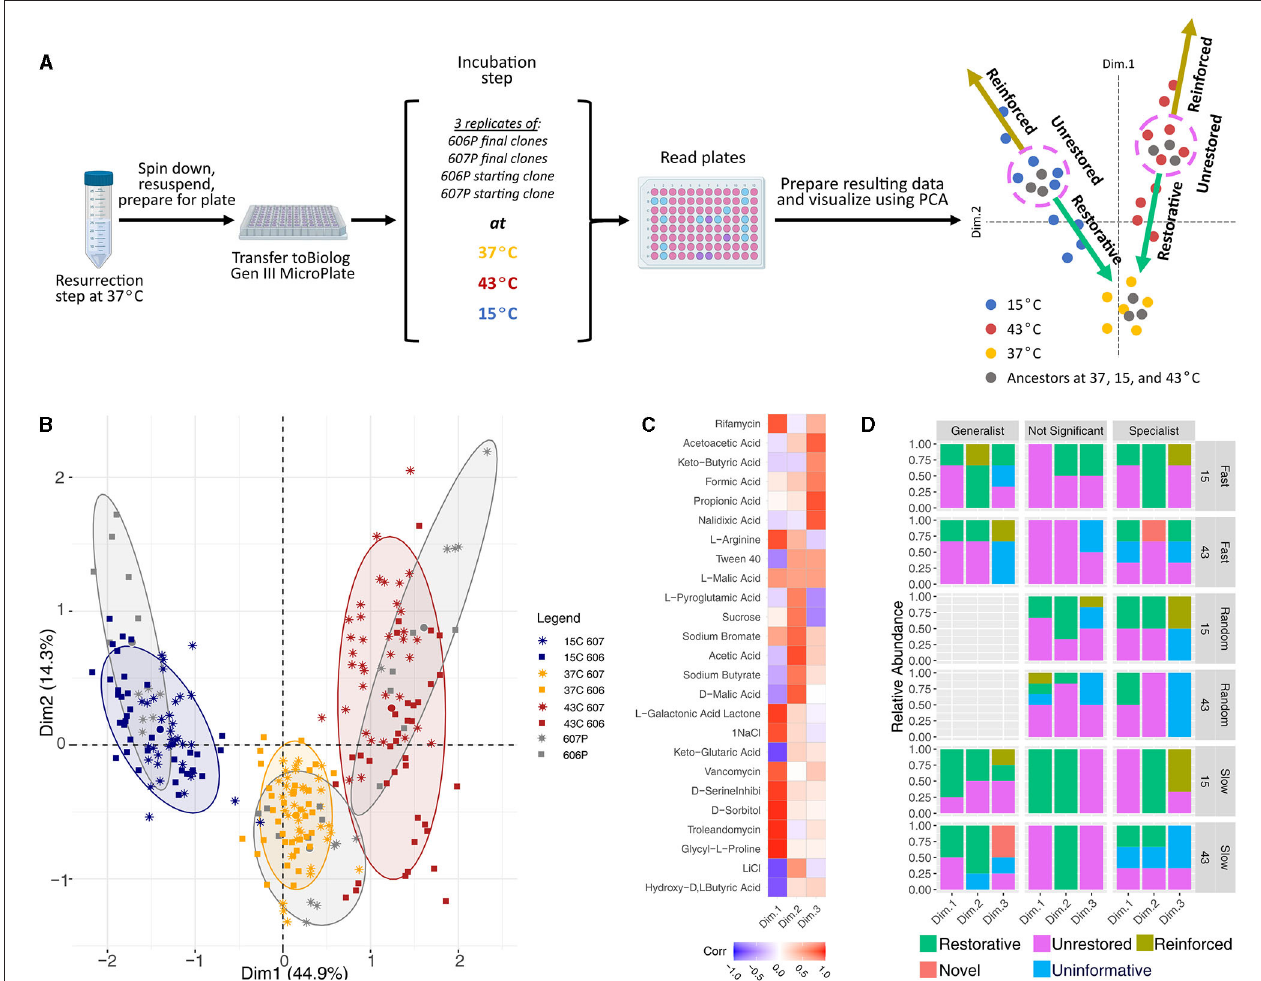
FIGURE 4 | Biolog experimental schematic and data analysis results. (A) Diagram of the Biolog experiment in the three temperatures used in our laboratory evolution experiment. (B) Principal component analysis of the phenotypic fingerprint data. The colors indicate the temperature treatments of the Biolog plates (15, 37, and 43 ◦ C) and our reference starting strain’s response at those temperatures. The larger dots mark the centroids of the clusters of our starting strains at each of the three temperatures. The axes shows the amount of variance explained by each of the components. PCA was obtained with the function FactoMineR::PCA() . PCA visulations employed factoextra::fviz_pca_ind(…, addEllipses=TRUE, ellipse.level = 0.8) with concentration ellipses that are drawn around each group using a multivariate normal distribution with the size of concentration ellipses as 0.8 in normal probability. (C) The correlations between the plate wells and the first 3 PCA dimensions, where the plate wells chosen were the top 10 wells that contributed to each of the three dimensions. (D) Restoration results for the Biolog data. Generalists, specialists, and not significant strains are shown. The results are also separated by the temperature condition the Biolog plates were grown at, and the experimental evolution environmental fluctuation treatment. The clones classified as generalists had more restorative and novel responses than specialists and non-significant strains combined ( p -value = 0.030 and 0.075, respectively), and more restorative responses when compared to specialists alone when 15 and 43 ◦ C conditions were combined ( p -value = 0.087). Generalist strains also had more novel and restorative responses than non-generalist strains at 43 ◦ C alone ( p -value = 0.075 and 0.062), and have less unrestored responses than non-generalist strains at 43 ◦ C alone ( p -value =